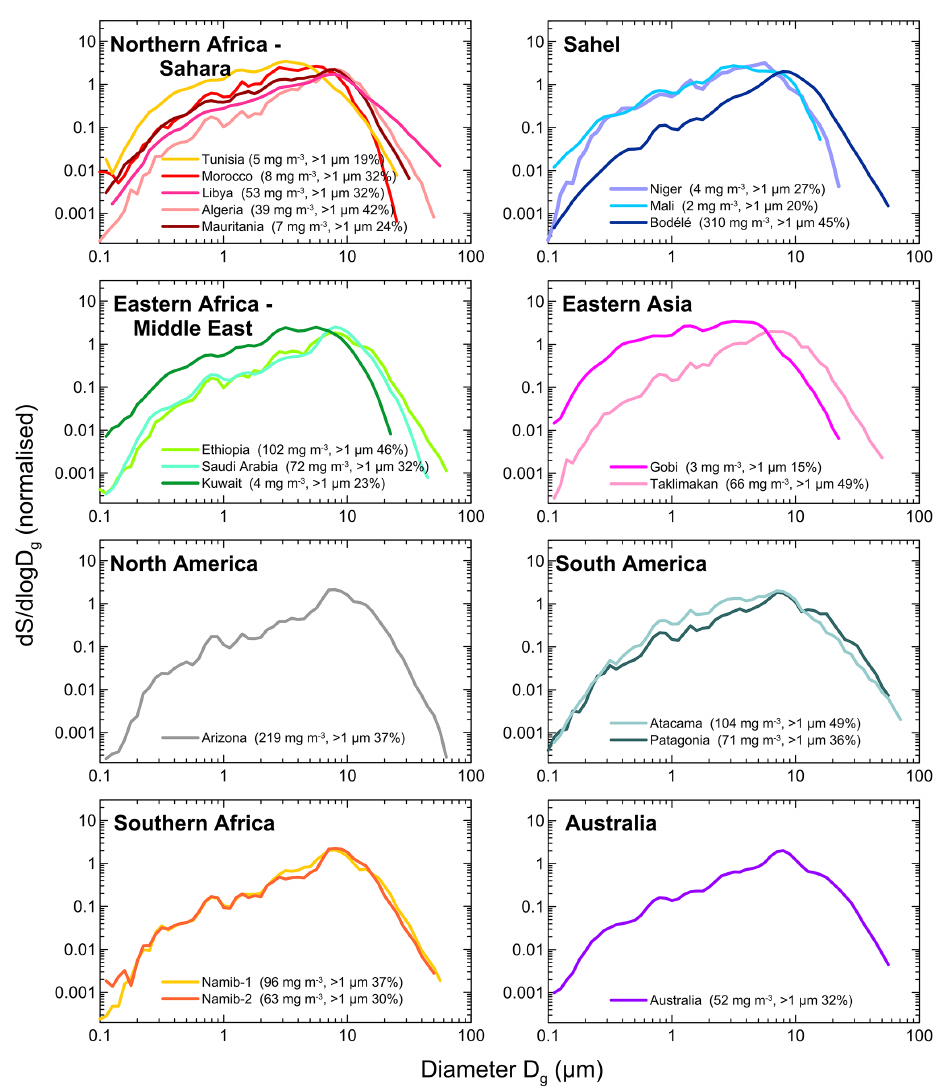
Figure 5. Surface size distributions in the CESAM at the peak of dust injection for all cases analyzed in this study; the total measured dust mass concentration and the percentage of the super-micron to sub-micron number fraction at the peak are also reported in the legend.